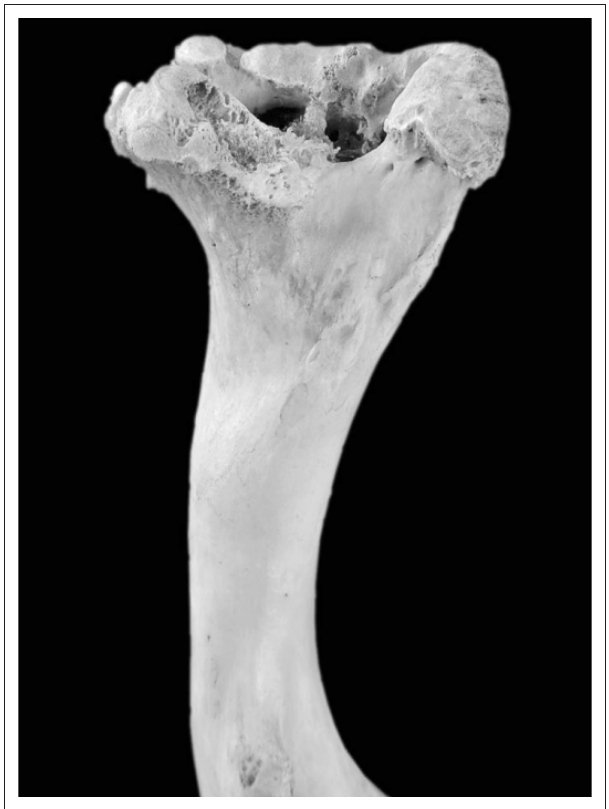
FIGURE 8: Humerus of an adult Nile crocodile, case 5: Collapse of the distal articular surface of the